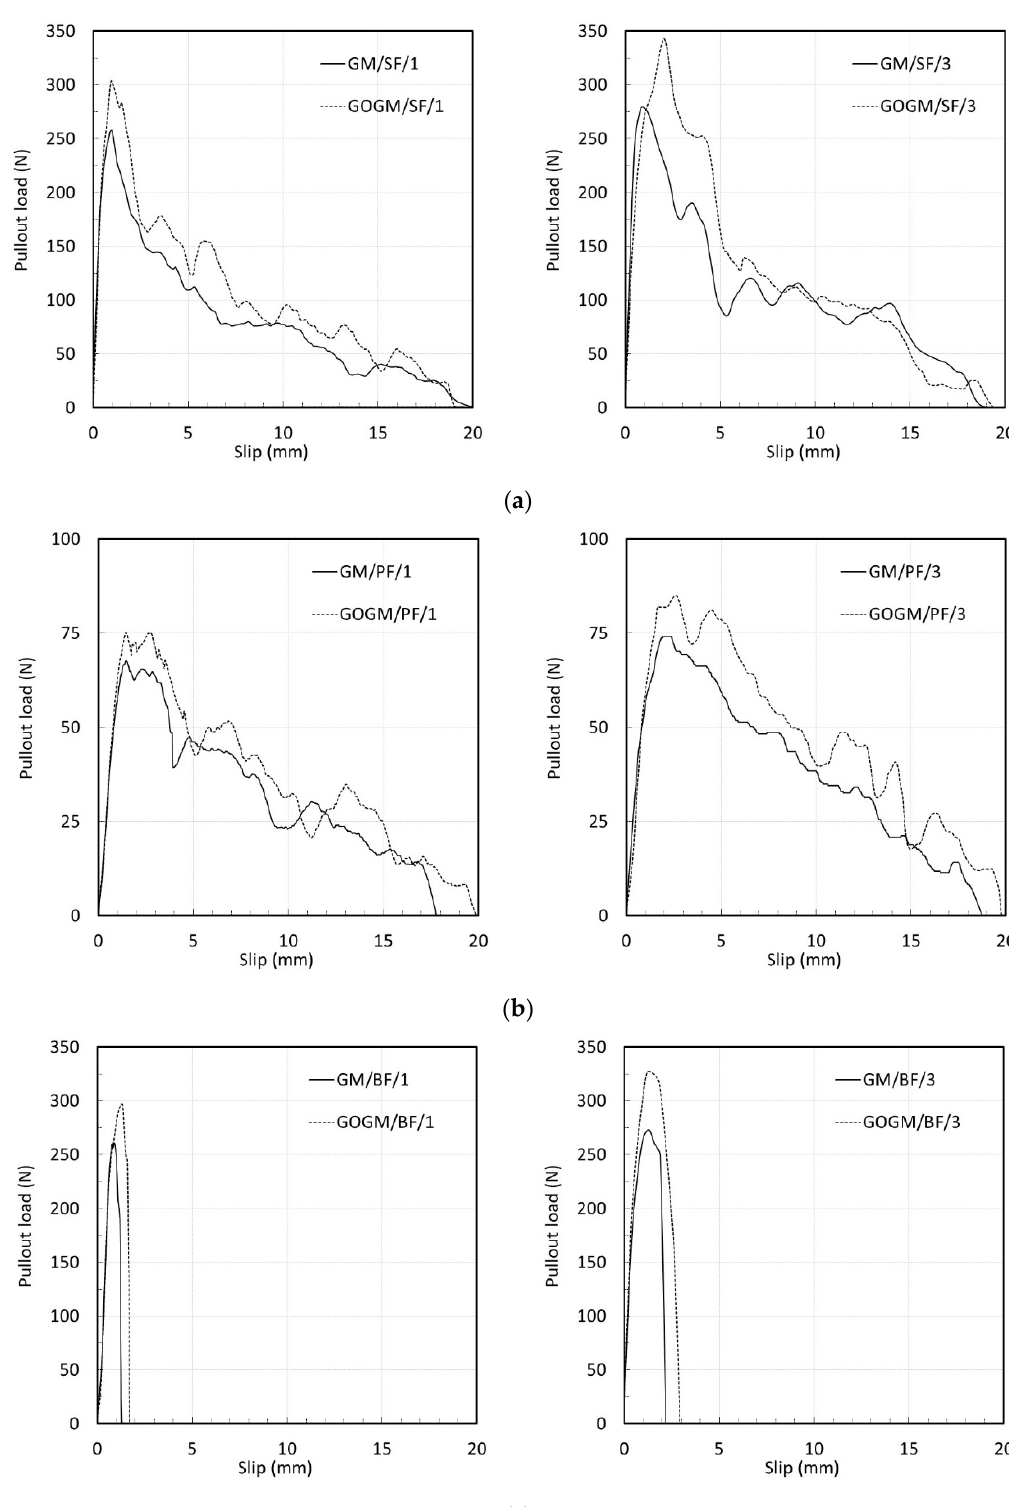
Figure 6. Effect of graphene oxide on bond-slip responses of: ( a ) SF, ( b ) PF, and ( c ) BF.